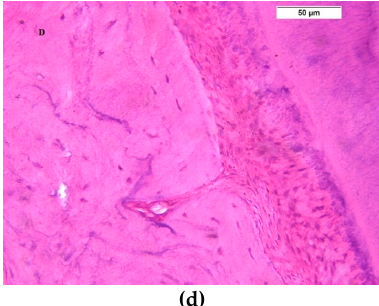
Figure 4. Four weeks interval. ( a ) Control group: Photomicrograph showing the normal periodontal healthy tissues (H&E 200×); ( b ) Photomicrograph of SRP group showing healed periodontal ligament tissue with wide periodontal space and periodontal cells which are lower in number and not organized (H&E 400×); ( c ) Photomicrograph of ADSCs group showing highly well-organized proliferating periodontal tissue perpendicular to the cementum and bone (yellow arrows) (H&E 400×), multiple blood vessels (white arrow) and osteoid tissue, as shown in ( /C ); ( d ) Photomicrograph of Exo. group shows a narrow periodontal ligament space of uniform thickness filled with a highly organized proliferating periodontal ligament tissue attached to a regular cementum surface and well-formed dense healthy bone (H&E 400×).